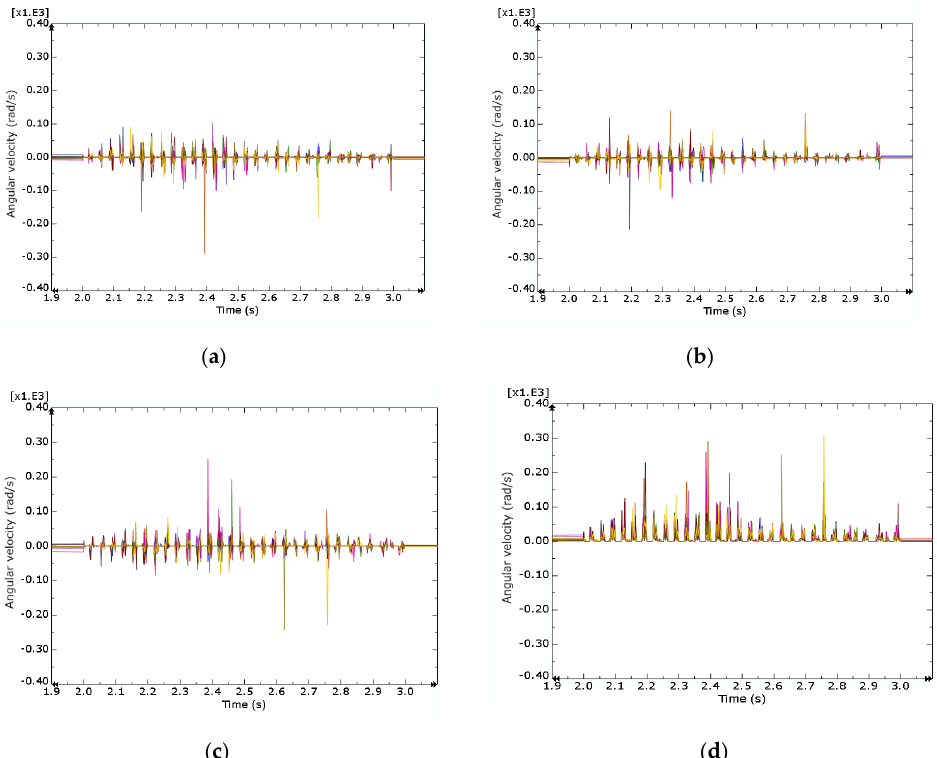
Figure 10. Angular velocity of AC 11 aggregate with a paving speed of 4 m/min: ( a ) in X-direction; ( b ) in Y-direction; ( c ) in Z-direction; ( d ) combined angular velocity.